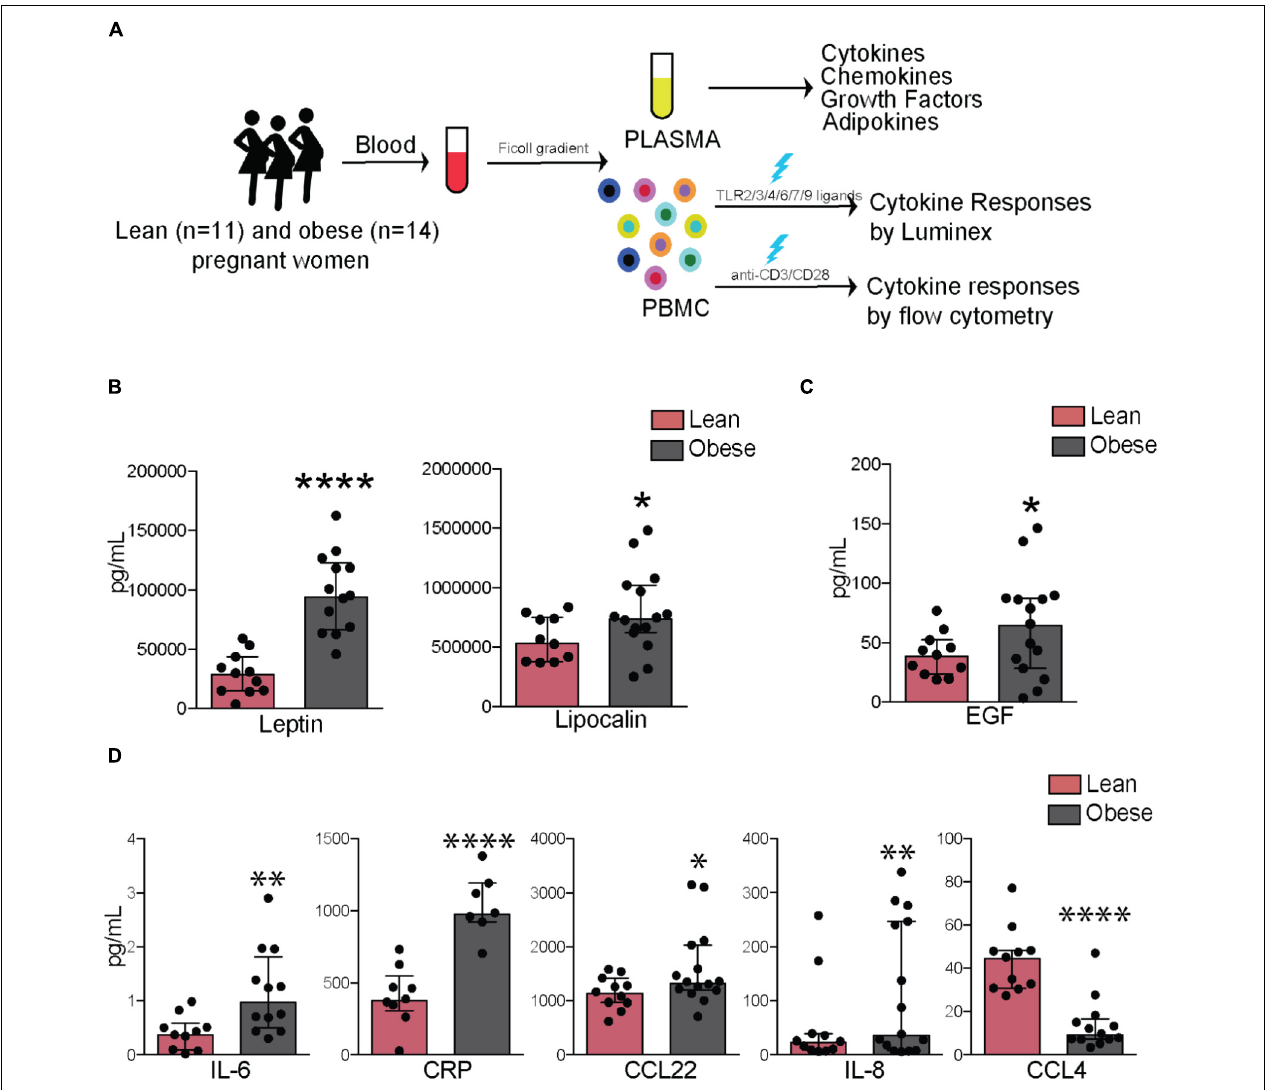
FIGURE 1 | Pregravid obesity alters plasma levels of inflammatory mediators. (A) Study design: circulating factors in plasma were measured using Luminex and ELISA while frequency and cytokine production by immune cell subsets were quantified using flow cytometry. (B) Plasma levels of leptin and lipocalin 2. (C) Plasma levels of EGF. (D) Circulating levels of canonical markers of inflammation-IL6 and CRP as well as chemokines CCL22, IL8, and CCL4. Significant differences between groups are indicated as follows: ∗ p < 0.05, ∗∗ p < 0.01, ∗∗∗ p < 0.001, and ∗∗∗∗ p < 0.0001. All of the bar graphs show median values with interquartile ranges (IQR).